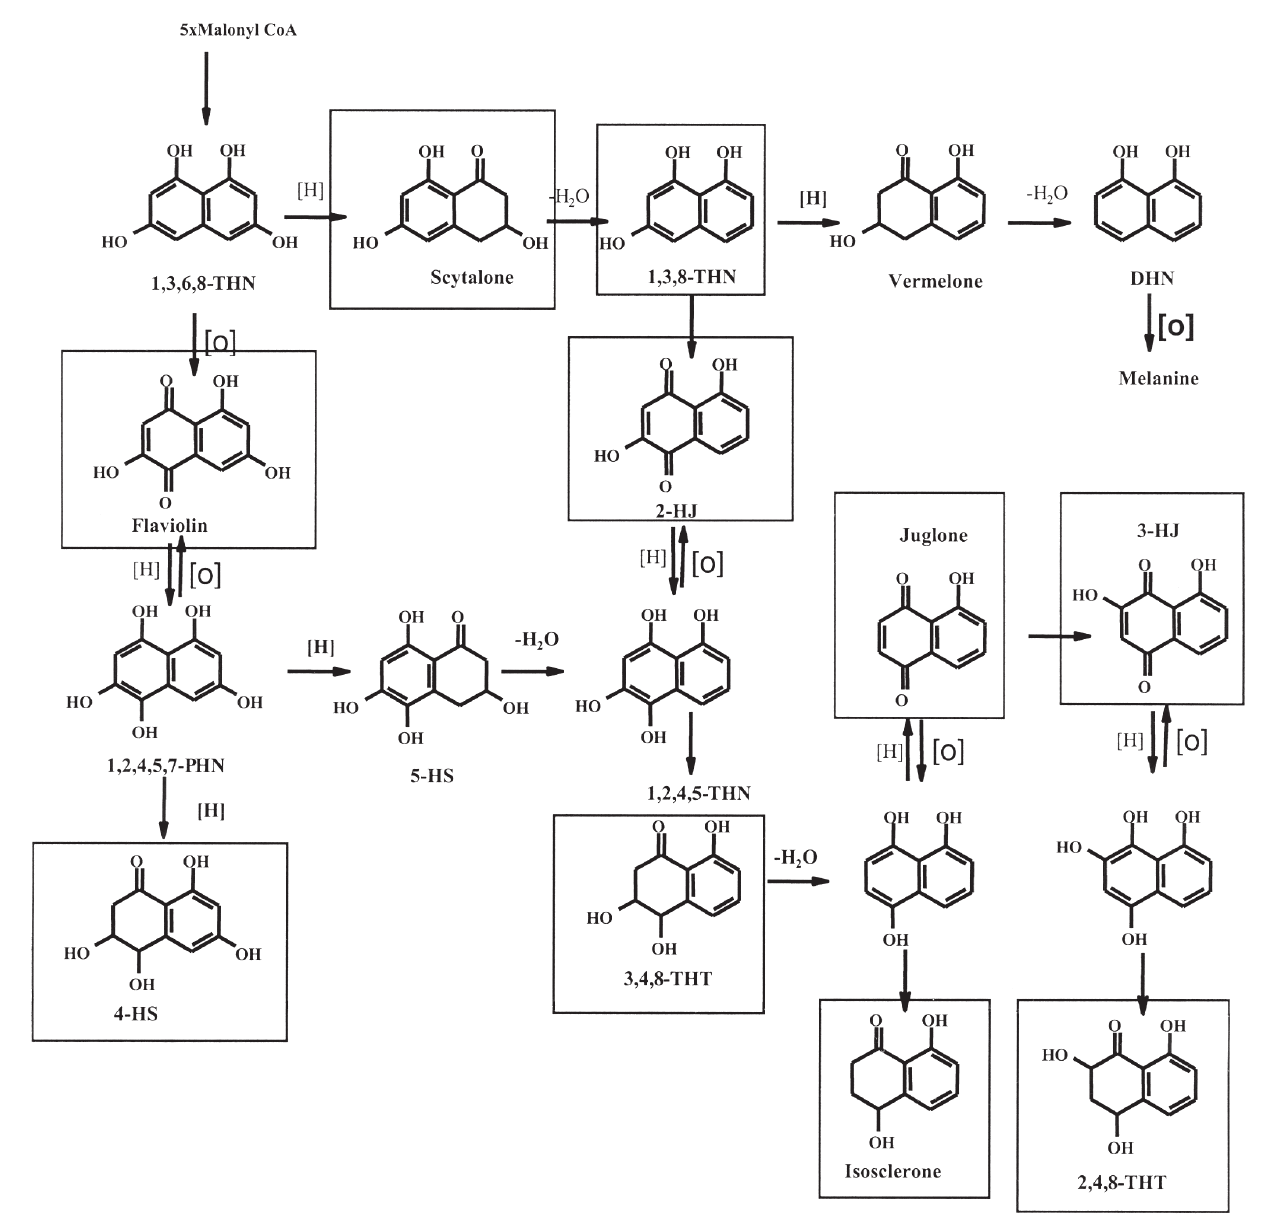
Fig. 1. The pentaketide pathway of melanin synthesis with flaviolin and 2-HJ branch pathways redrawn after Wheeler (1985) highlighting the isolated